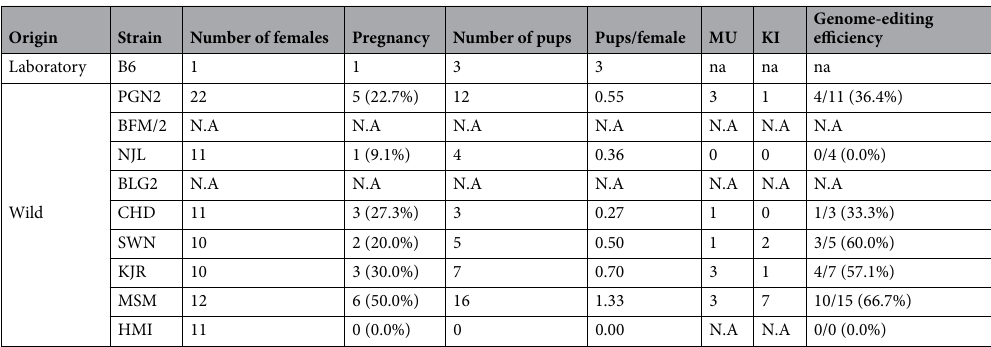
Table 4. Efficiencies of genome editing upon application of i -GONAD with 3 transfer pulses (TP:3). N.A . not